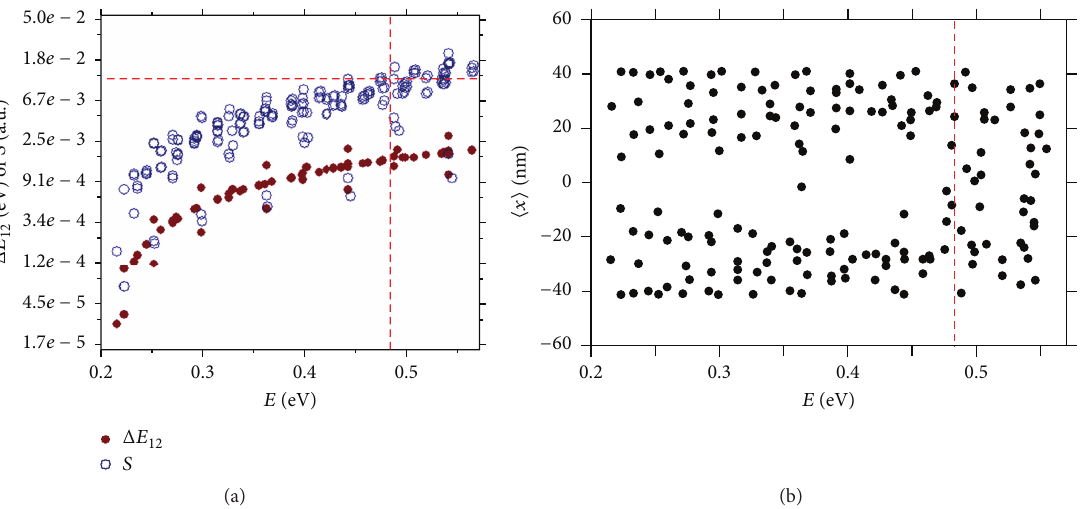
Figure 10: (a) Energy differences Δ𝐸 12 (solid circles) and overlap integrals 𝑆 (open circles). (b) Average coordinate ⟨𝑥⟩ along single electron spectrum for the asymmetric DQW for asymmetry parameter 𝜉 = 𝑅 2𝑦 /𝑅 2𝑥 , 𝜉 = 39.75/40 = 0.99375 . The dashed lines divide Δ𝐸 12 and 𝑆 ranges in regions of mainly localized and mainly delocalized